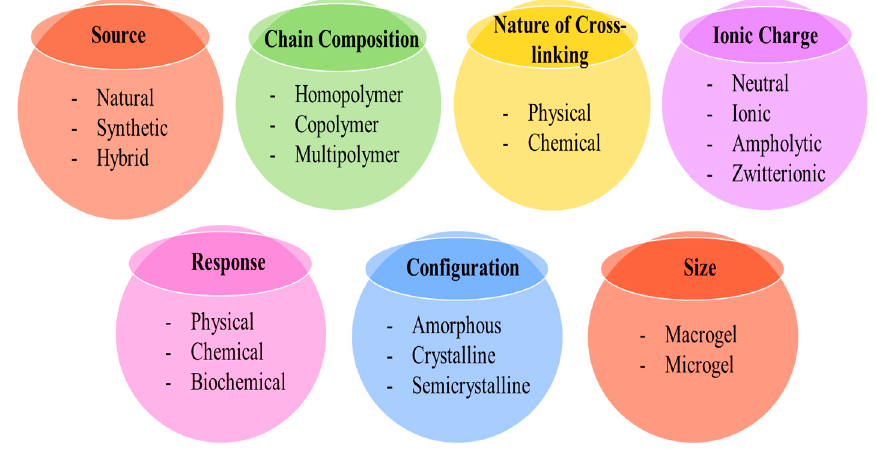
Figure 5. Classification of hydrogels.